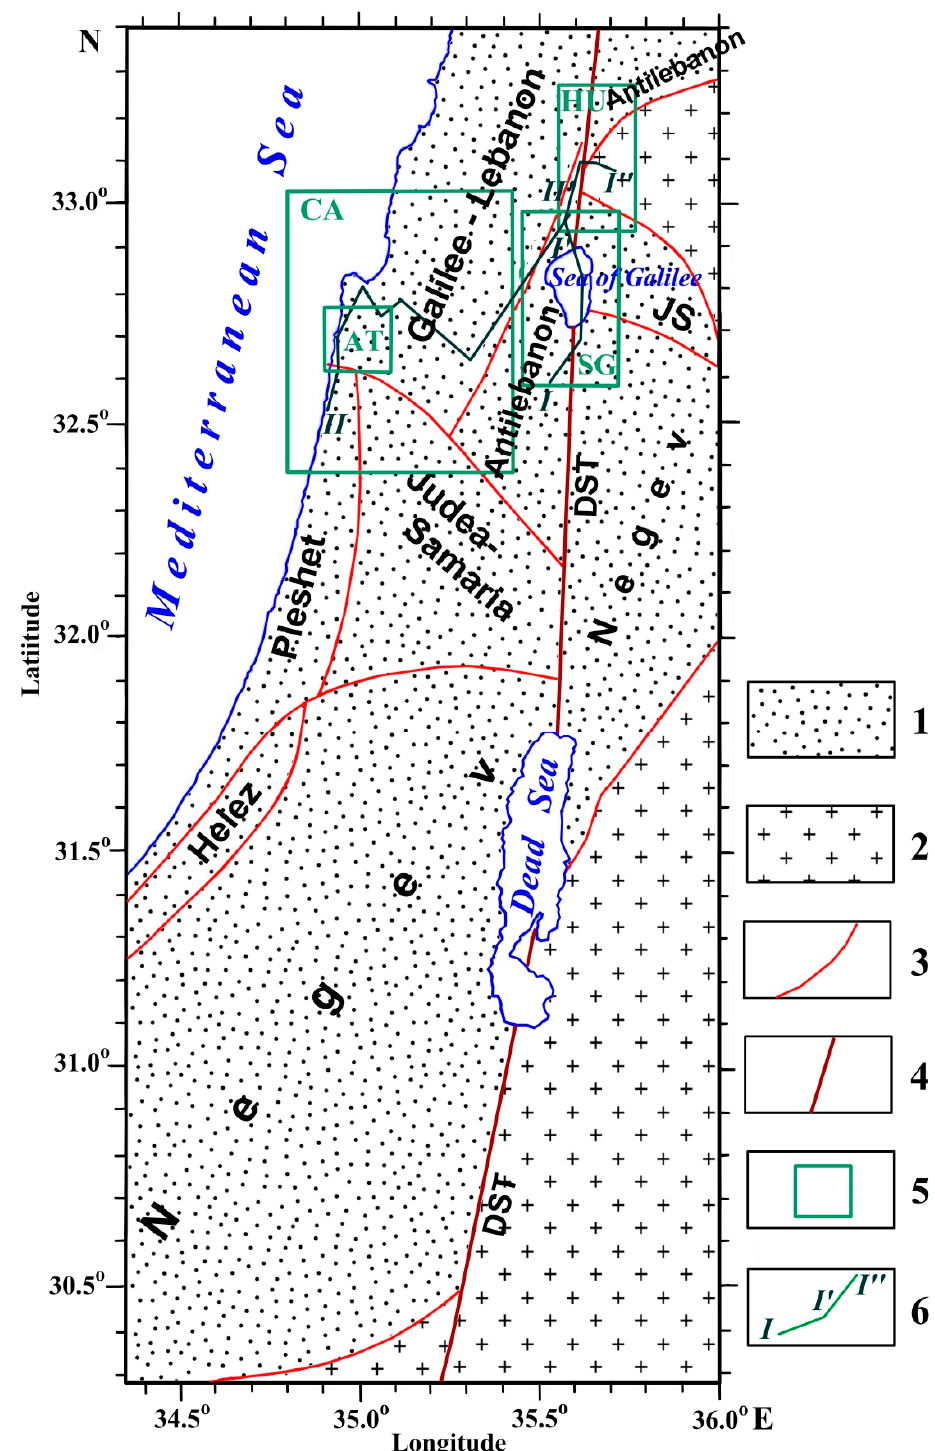
Figure 1. Very simplified structural map of with location of areas of paleomagnetic-radiometric generalization and examined magnetic anomalies. (1) Mesozoic Terrane Belt, (2) Neoproterozoic Belt, (3) intraplate faults, (4) interplate Dead Sea Transform (DST), (5) paleomagnetically investigated areas: CA, Carmel, AT, Atlit, SG, Sea of Galilee (Lake Kinneret), HU, Hula, (6) location of paleomagnetic profiles I – I ′ – I ″ and II – II ′ . JS, Judea-Samaria.